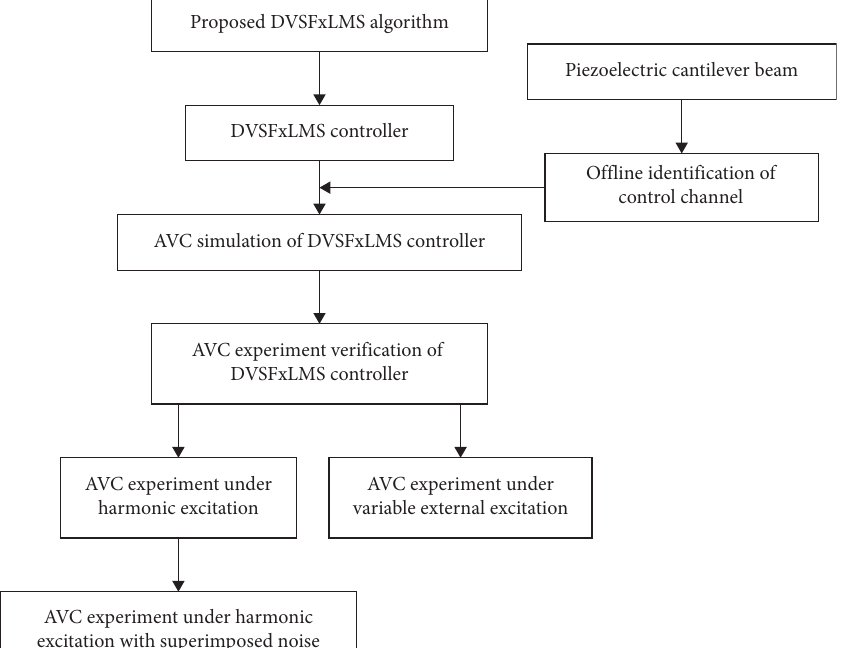
Figure 2: The block diagram of the proposed research.